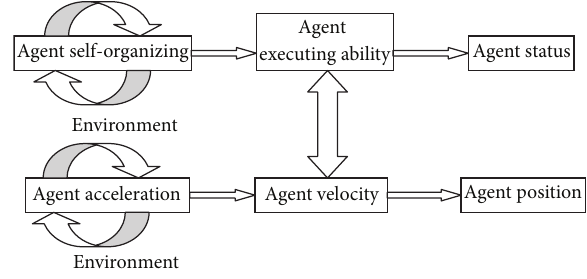
Figure 2: MAS mapping of supply chain.